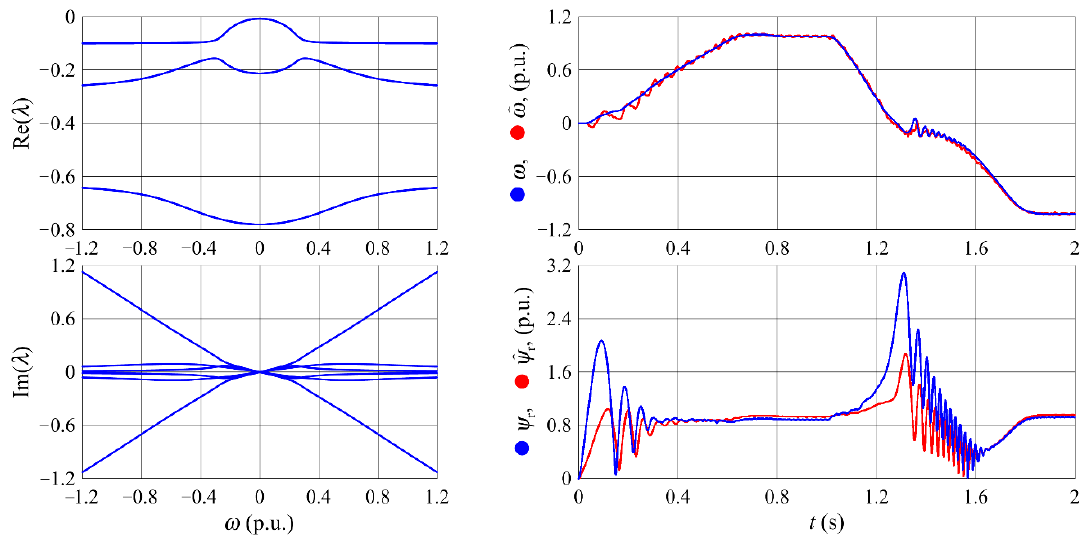
Figure 8. The eigenvalues and simulation results obtained for the PIr observer.